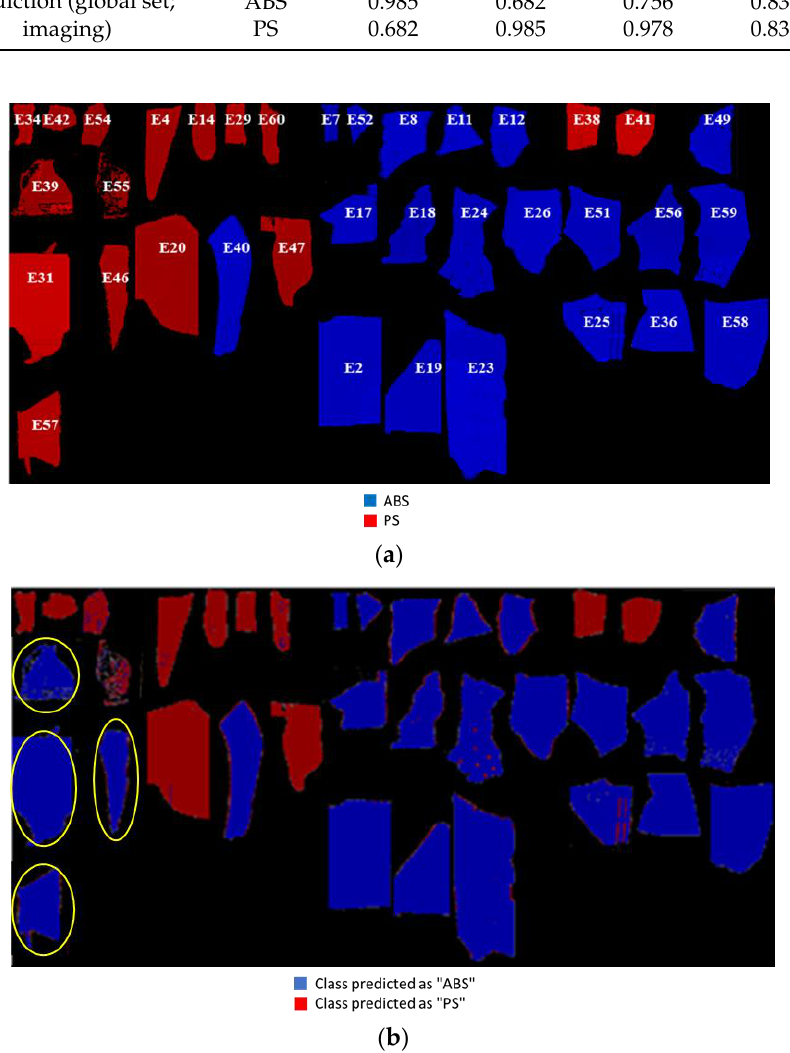
Figure 9. True class membership ( a ) and class prediction most probable for SisuCHEMA XL™ obtained after the application of the PLS-DA model on the global set hyperspectral images mosaic ( b ). Blue = “ABS” class; red = “PS” class. Samples circled in yellow were incorrectly identified.